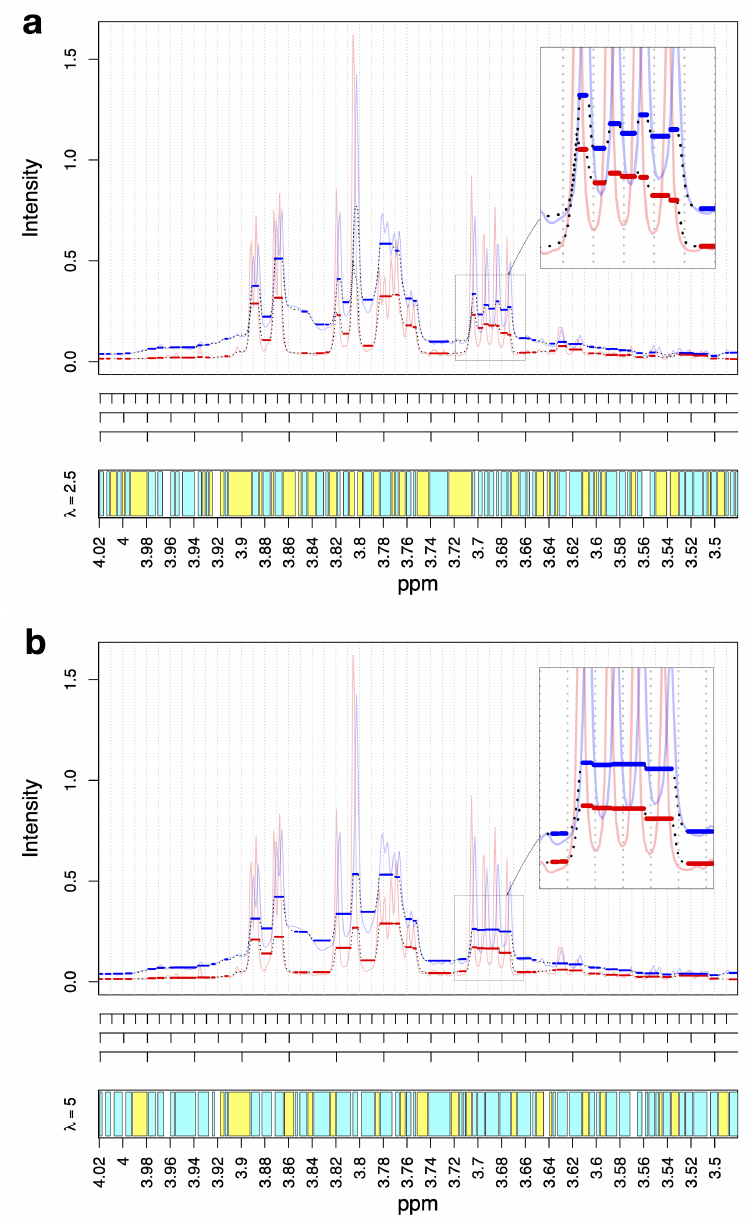
Figure 1. ( a , b ) Exemplary NMR spectral regions that ranged from 4 ppm to 3.5 ppm, together with their corresponding BF fits for λ = 2.5 and λ = 5, respectively. The thin blue and red lines show the spectral intensities of two exemplary NMR spectra from the urinary AKI dataset. The black dotted lines show the corresponding BF fits, along which the plateaus of the fits are additionally highlighted as thick blue and red lines. The ticks in the middle of the figures correspond to the standard equidistant binning with bin sizes of 0.01 ppm, 0.02 ppm, and 0.04 ppm (from top to bottom, respectively). The lower parts of the figures display the detected consensus plateaus in cyan, which start and end at the same positions for all included spectra. The yellow blocks represent the regions that did not correspond to plateaus but were also retained for subsequent analysis. For both the yellow and cyan regions, we neglected those with widths ≤ 0.002 ppm, which are plotted as white blocks. The inserted figures show these dotted regions in